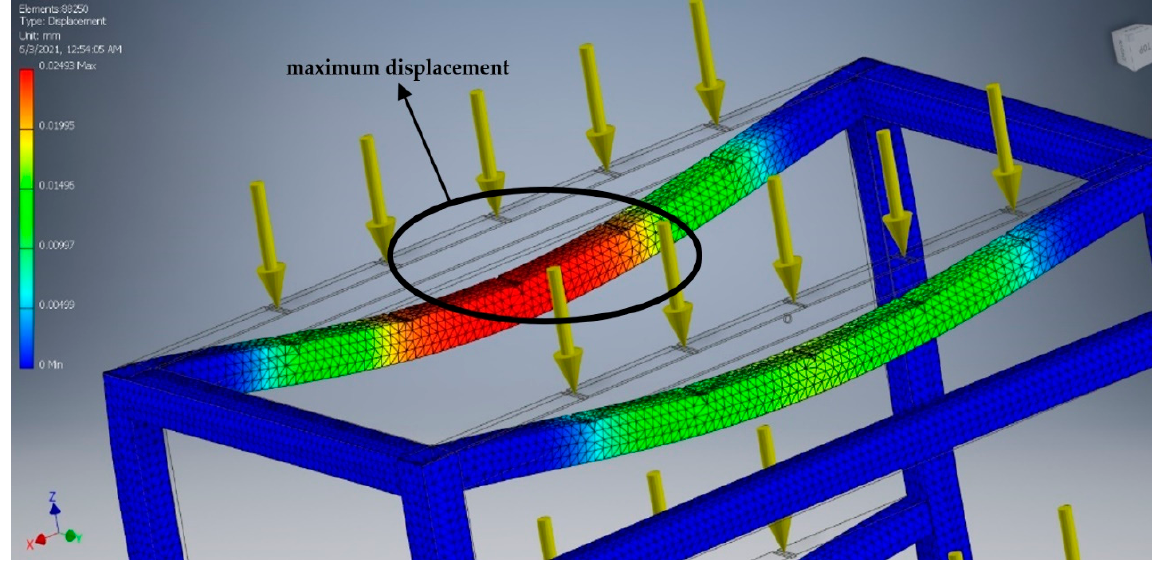
Figure 2. Stress simulation results for the frame (displacement).